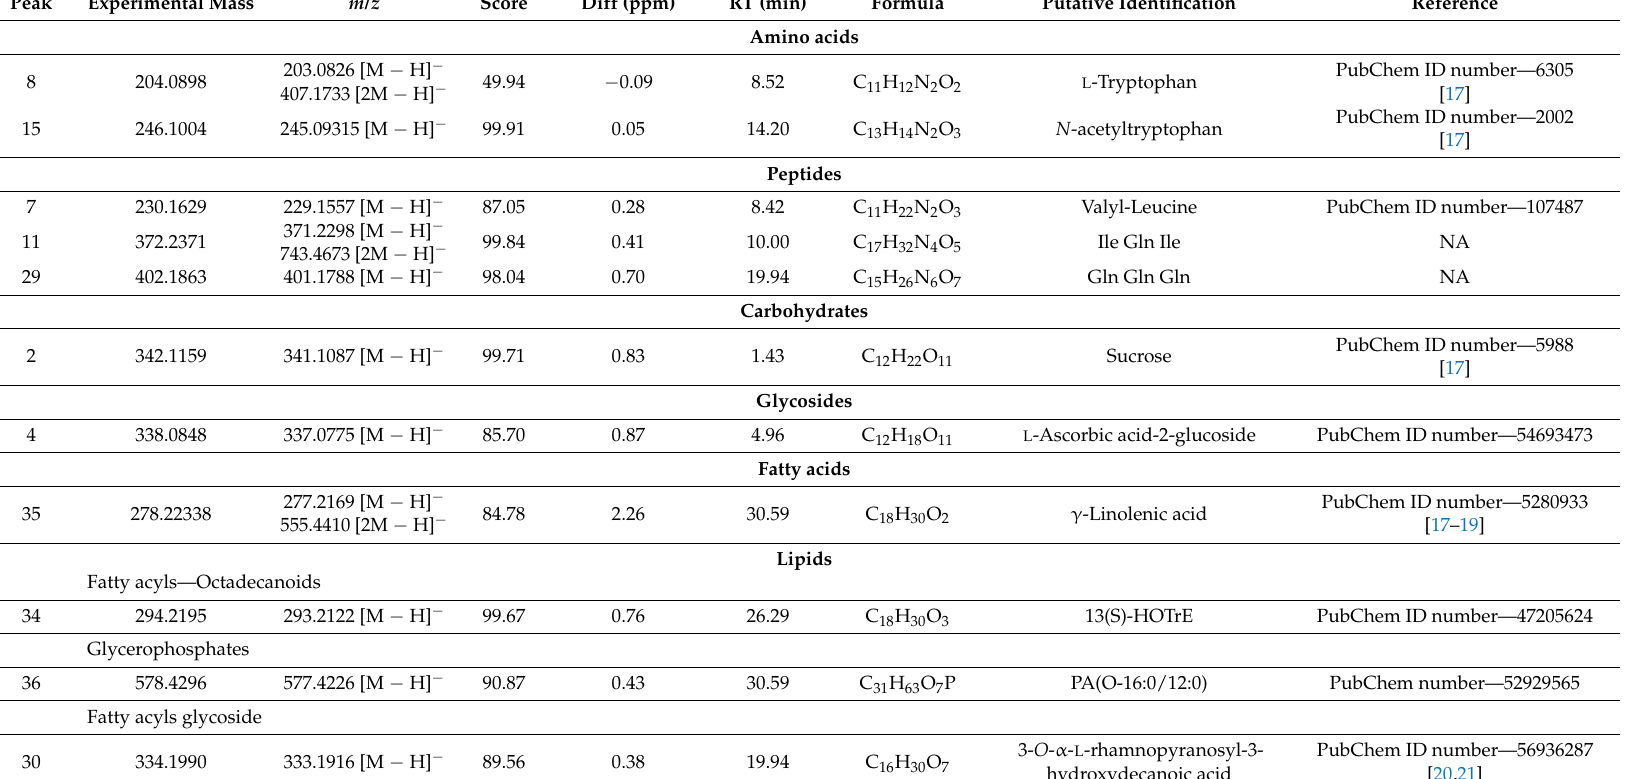
Table 1. Phytochemical compounds determined in bean leaves by LC-MS analysis, including experimental mass, m/z , score, retention time (RT), formula, their putative identity and related references. Data refer only to compounds that accumulated differentially in leaves of plants inoculated with the fungal isolates compared to